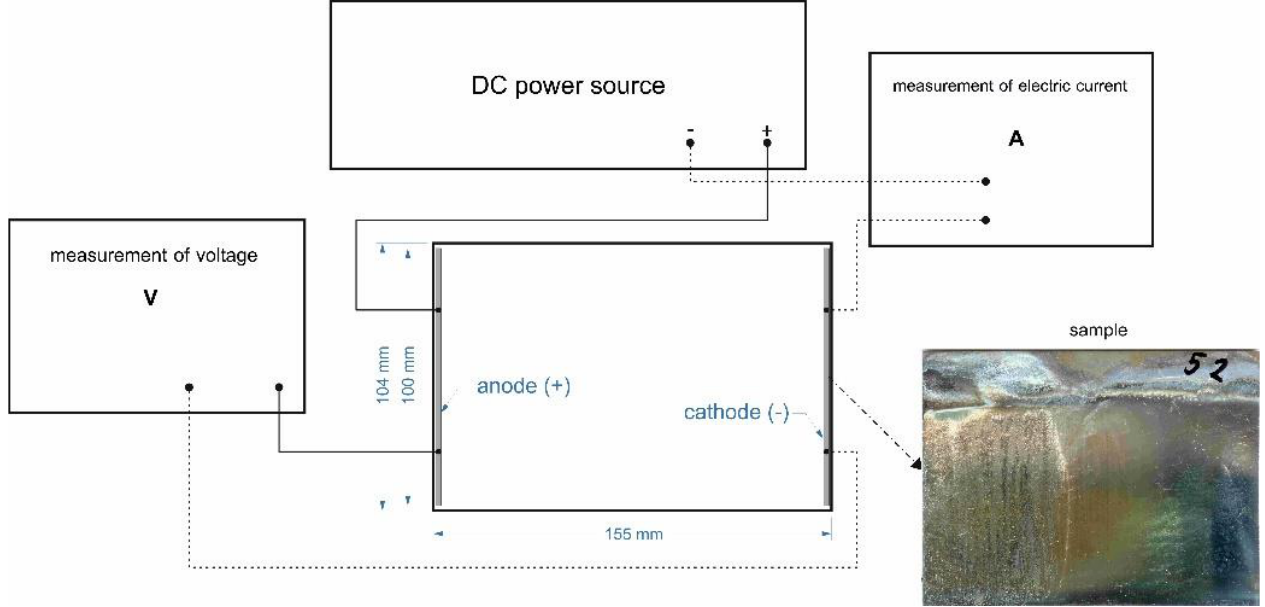
Figure 1. Connection diagram of the experimental apparatus. Table 1. Levels of factors (explanatory variables) used during the